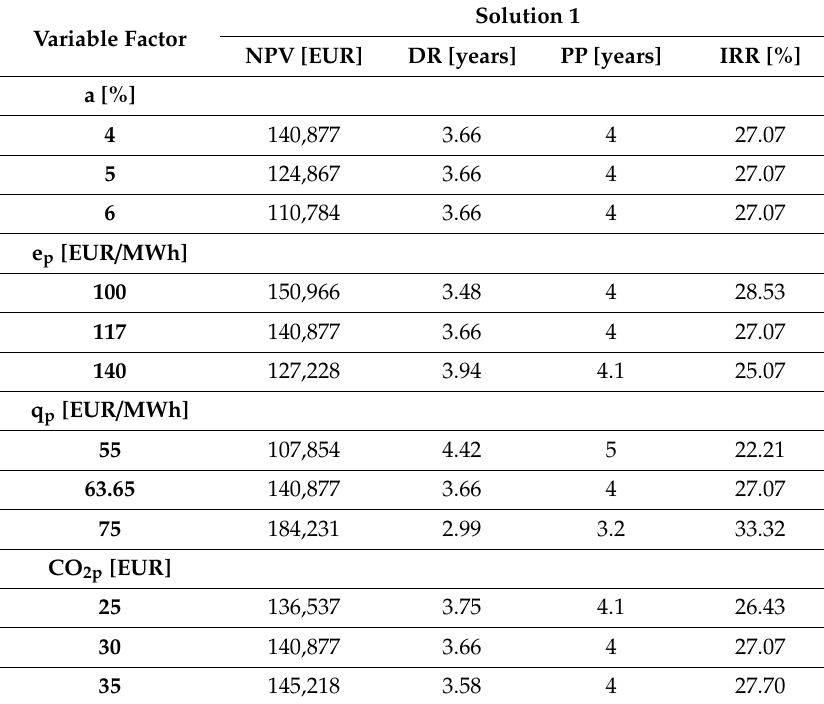
Table 5. Results of the sensibility